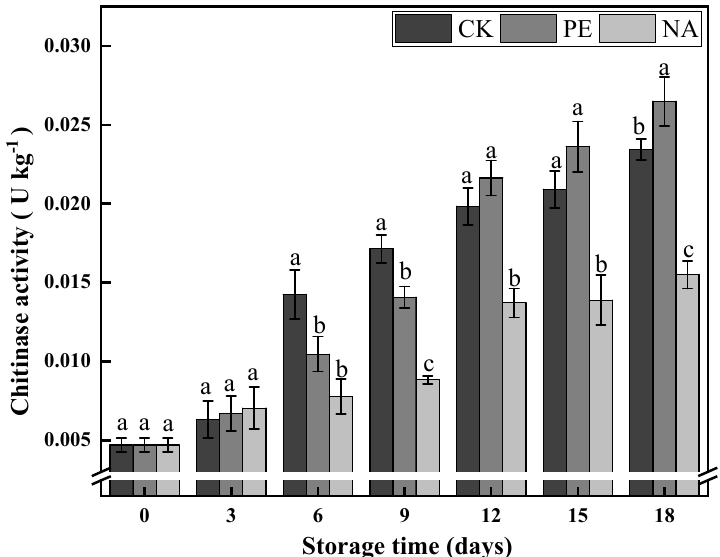
Figure 3. Effects of different types of packaging on chitinase activity in the elongation zone of postharvest F. velutipes stipes. Vertical lines indicate standard error ( ± SE), and different lower-case letters a, b and c indicate significant differences ( p < 0.05). All samples were kept in cold storage (4 ± 1 ◦ C) and relative humidity (80–90%) for 18 days. CK represents without any packaging, PE represents those packaged with PE plastic wrap, and NA represents those packaged with PE nano-film (the same as